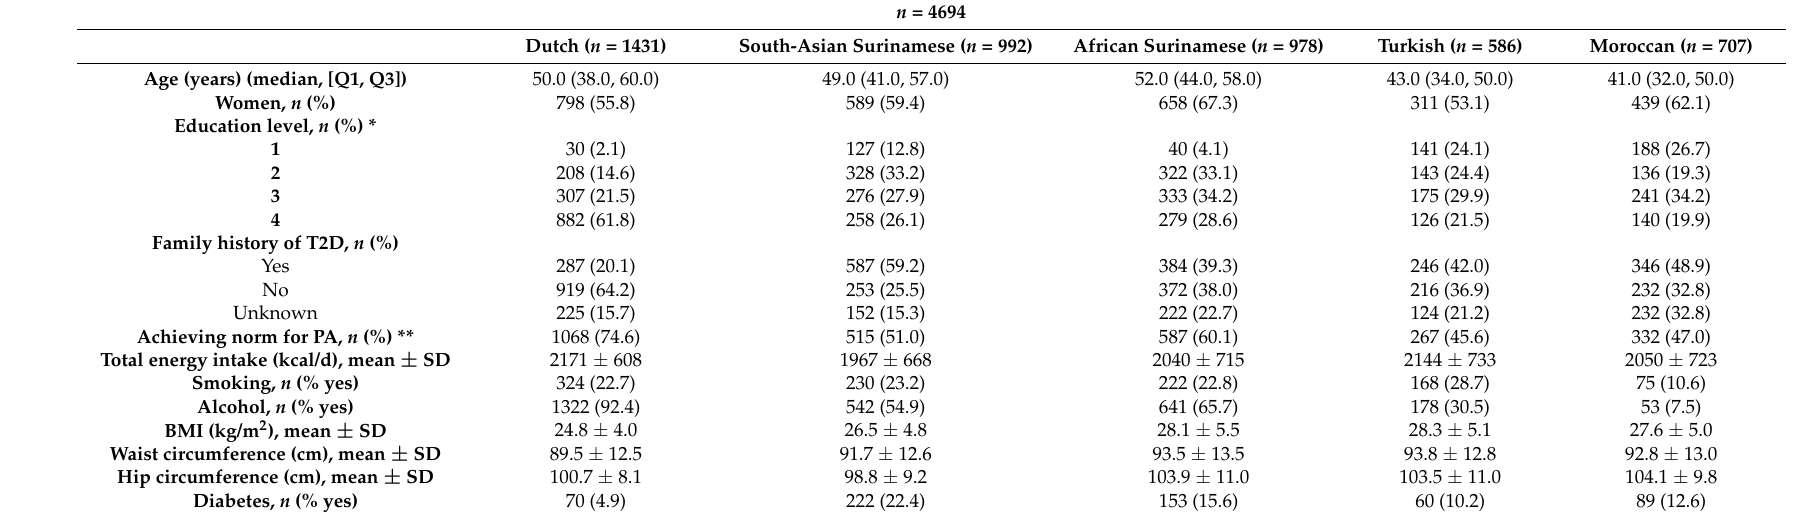
Table 1. Baseline characteristics of the study population, by